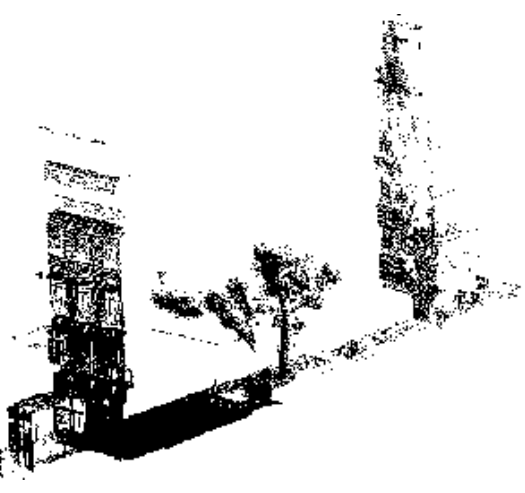
Figure 1. Outdoor MLS scan acquired with an MMS